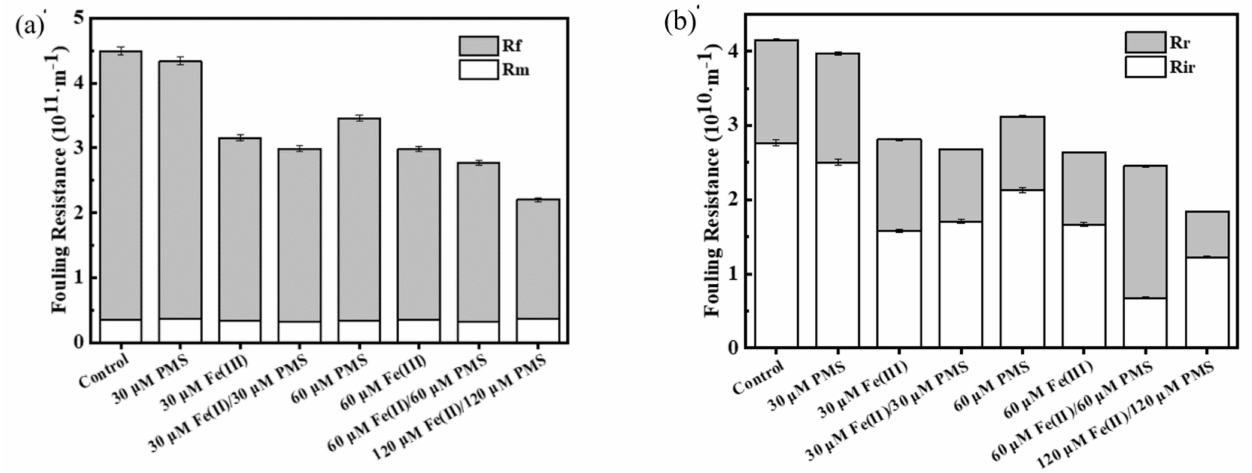
Figure 7. ( a ) Fouling resistance distributions of UF membrane ( R m ) and fouling cake ( R f ); ( b ) fouling resistance distributions of reversible ( R r ) and irreversible ( R ir )